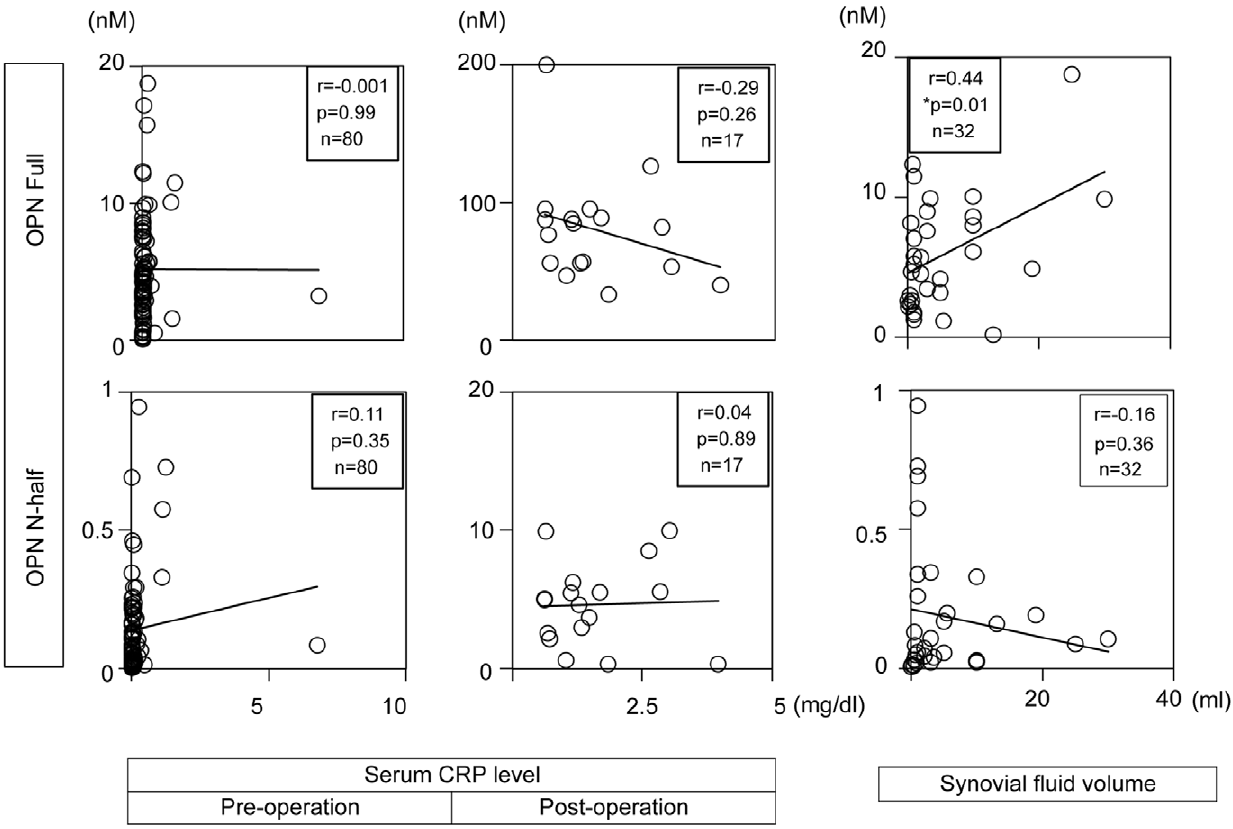
Figure 6. OPN Full and N-half levels in synovial fluid are independent from systemic inflammatory status but associate with joint inflammation. (Left and Middle panels) Blood samples were collected pre- and post-operation (at day 4) and serum CRP levels were quantified at the clinical laboratory of our university hospital. (Right panels) Synovial fluid was collected just before operation in a surgery room. Number of samples, correlation coefficient, and p value are indicated in each figure.